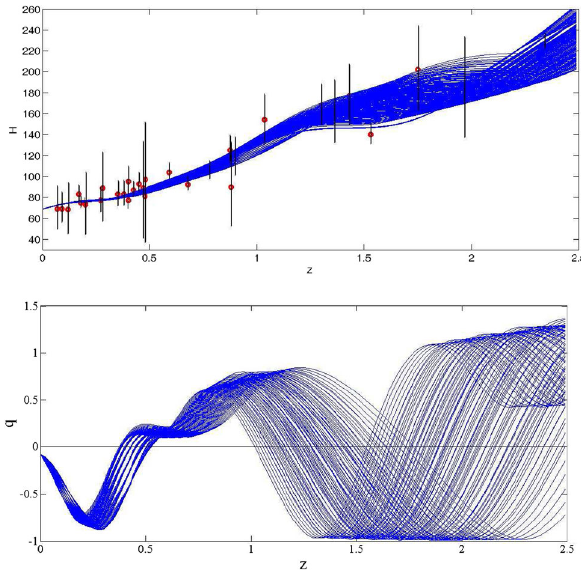
Fig. 8 The plot of H(z) and q(z) for Bootstrap